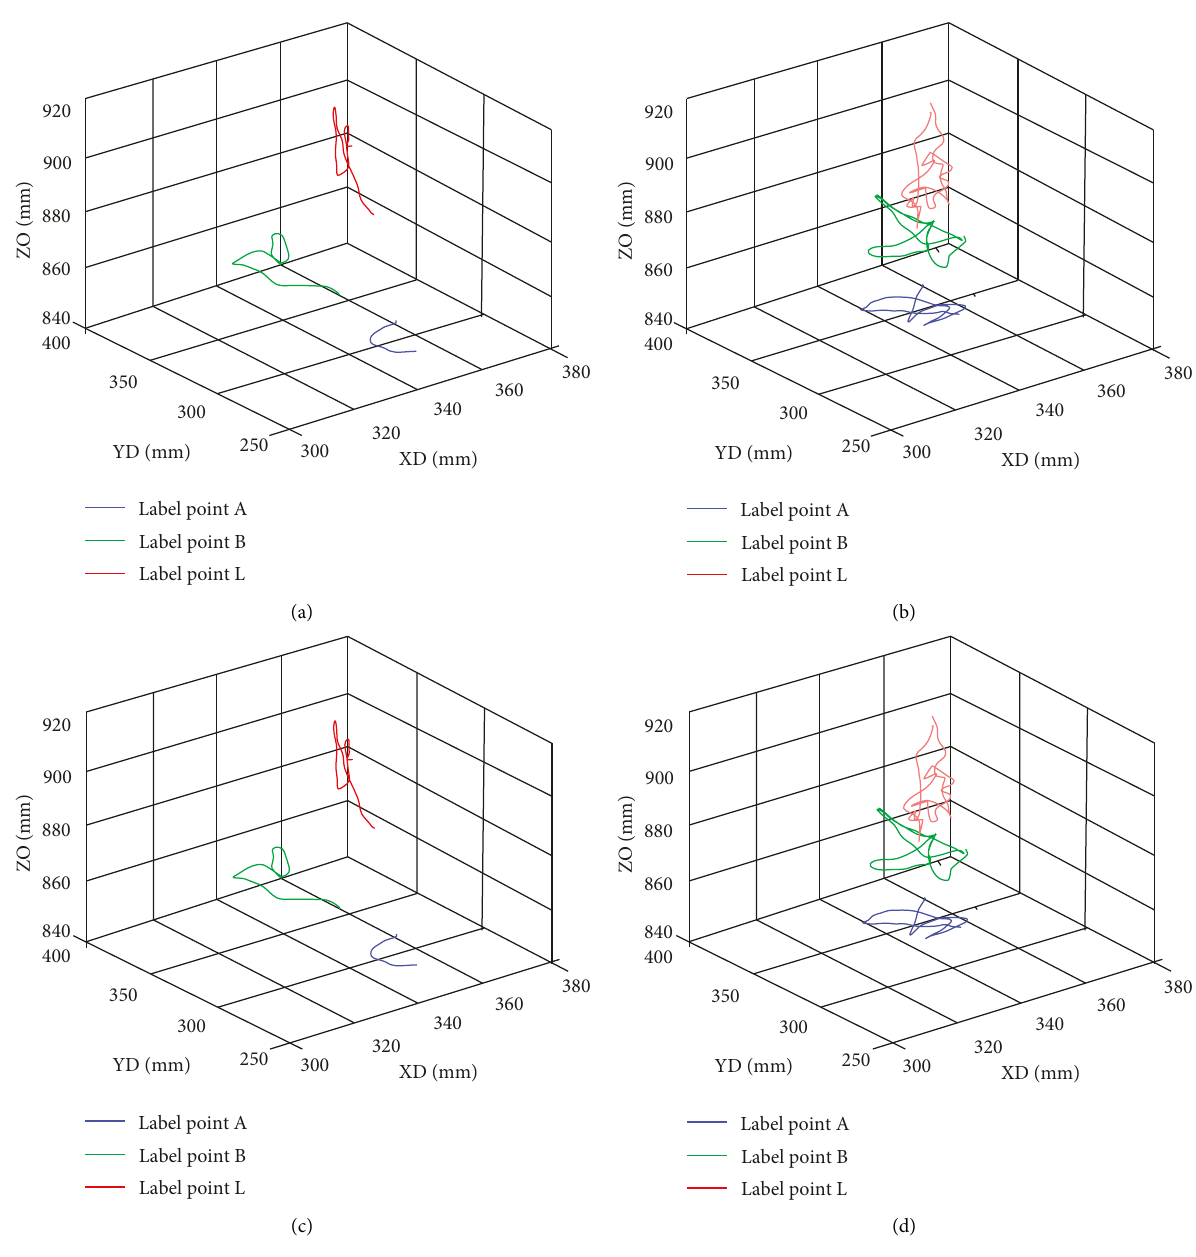
Figure 4: Marker motion trajectories obtained using the Phantom master hand and endpoint tracking trajectories based on the machine vision